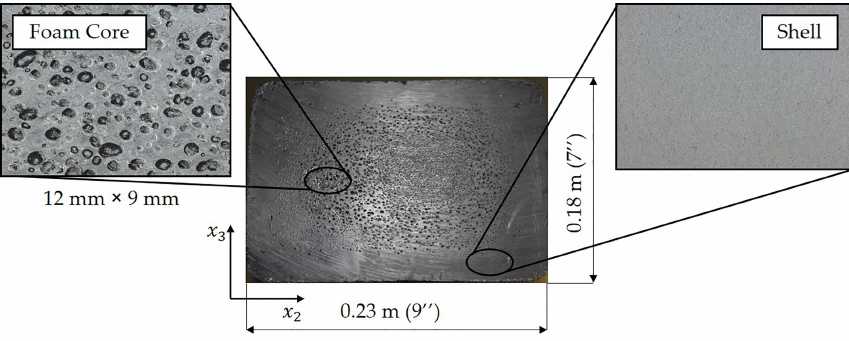
Figure 2. Cross-section showing the shell and foamed core regions of the